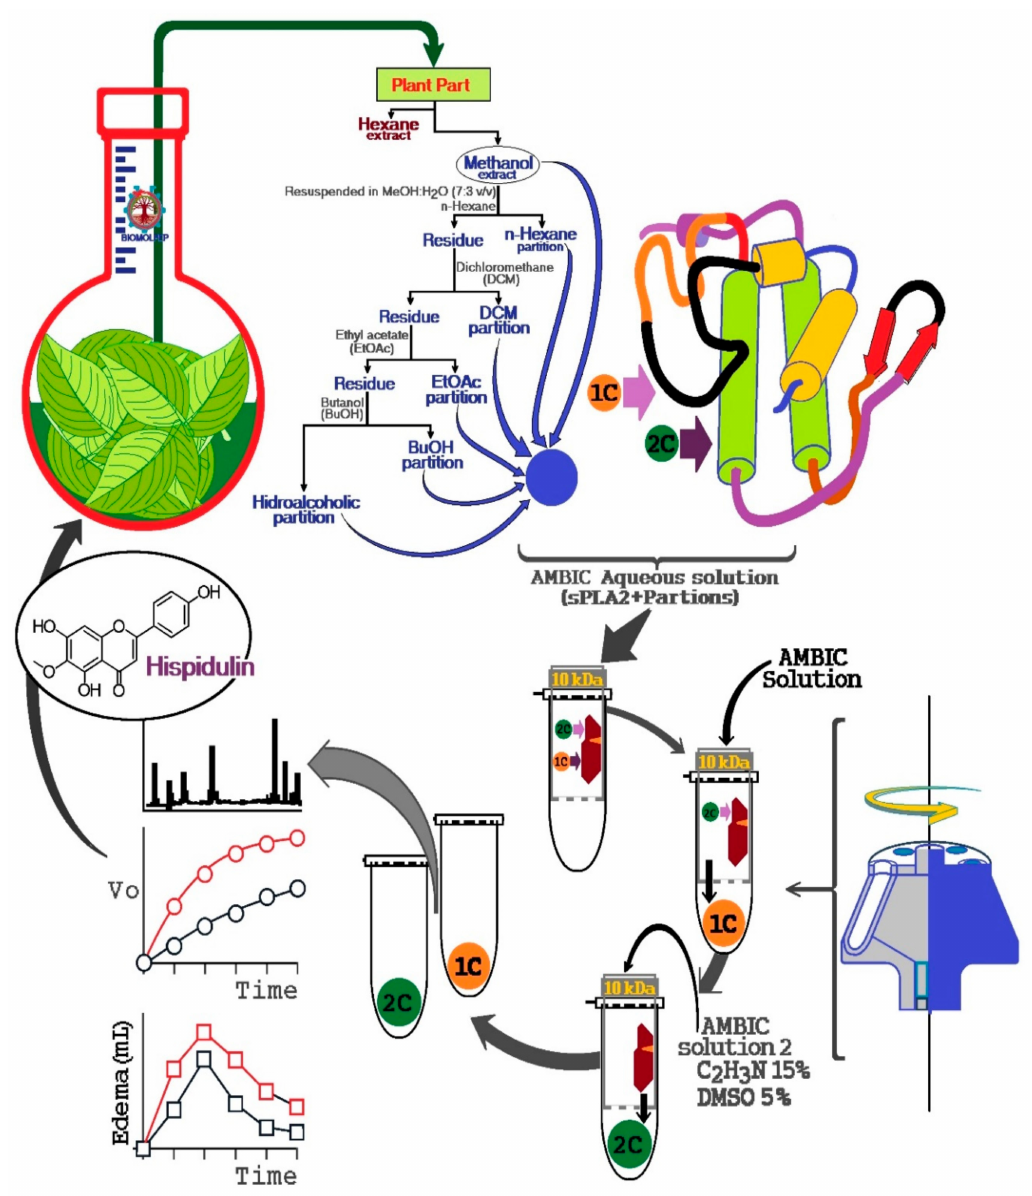
Figure 9. General scheme of screening natural compounds using secretory Phospholipase A2 as a target molecule for fishing for plant extract molecules and this method is intended to provide a tool to investigate potential molecules capable of modulating or inhibiting the pro-inflammatory actions induced by sPLA2 from plants or other organisms and to assess the importance of certain species among the biological diversity of a region as a potential producer of anti-inflammatory